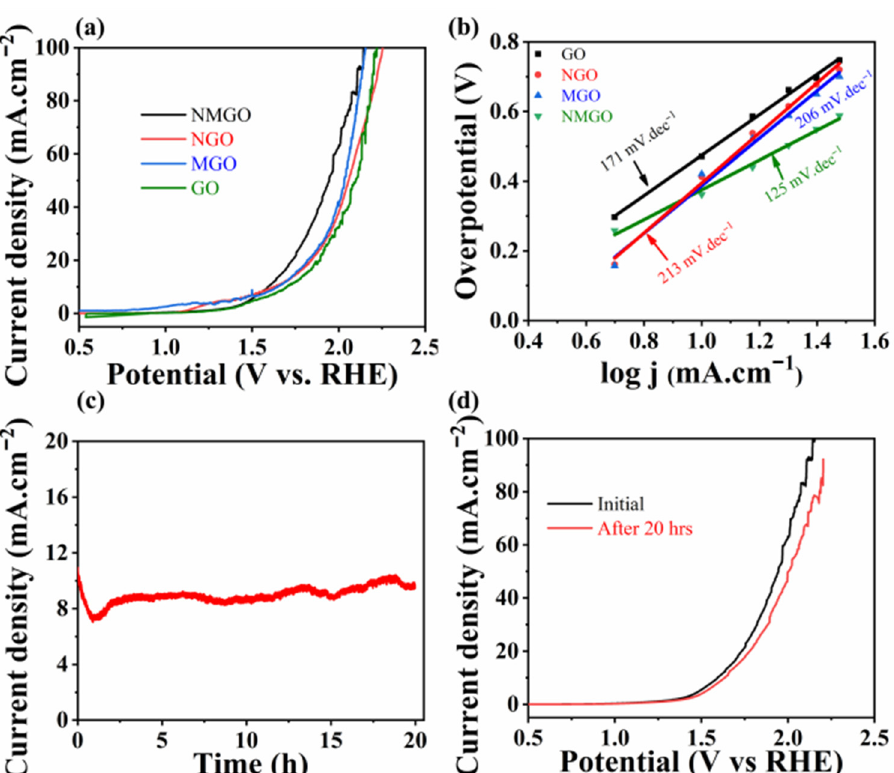
Figure 7 . ( a ) OER polarization curves for prepared electrocatalyst in 1 M KOH, ( b ) Tafel slopes calculated from corresponding LSV curves, ( c ) chronoamperometric of NMGO for 20 h in 1 M KOH, ( d ) LSV curves of NMGO at 10 mVs − 1 in 1 M KOH initially and after 20 h chronoamperometric test.